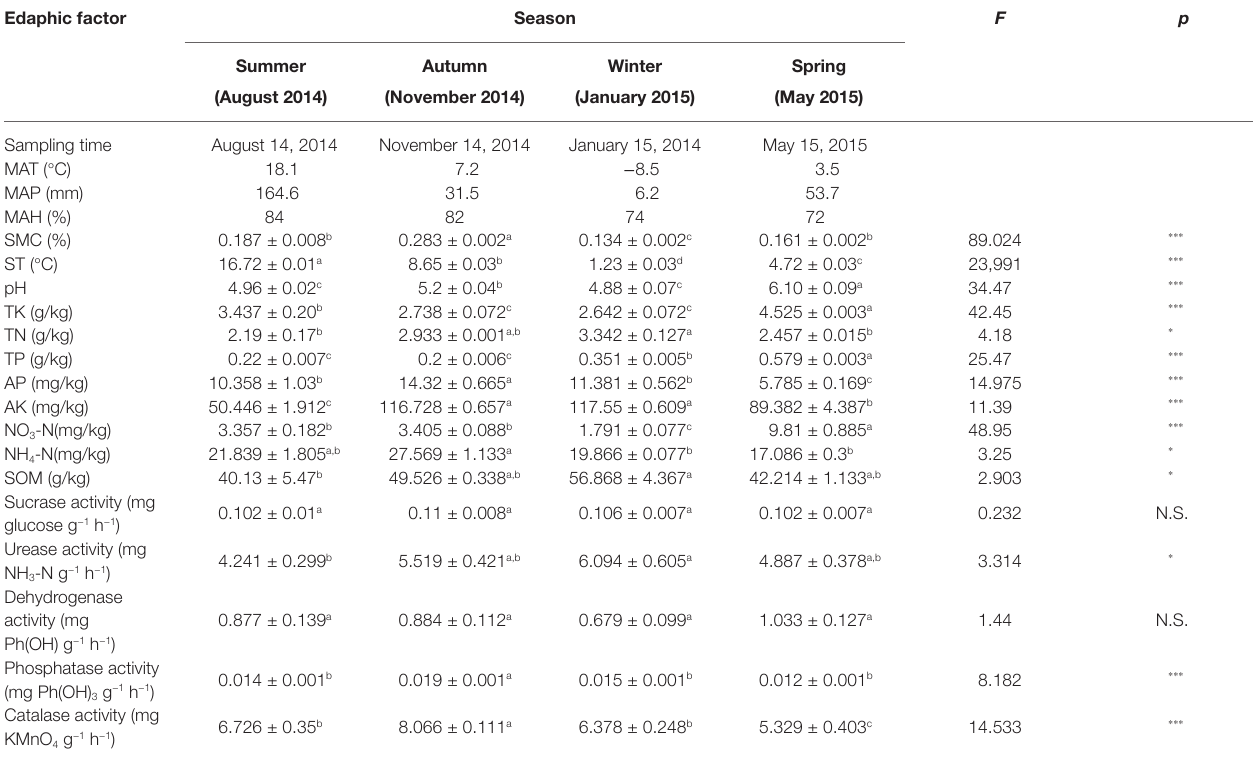
TABLE 1 | Edaphic factors and soil enzymatic activities in Pinus tabulaeformis forests located on the Qinling Mountains.